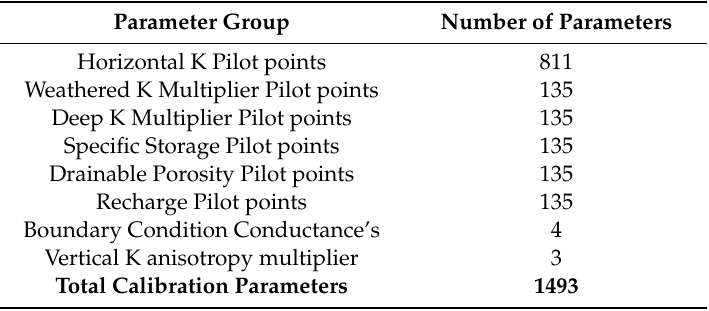
Table 2. Iterative Ensemble Smoother (IES) model